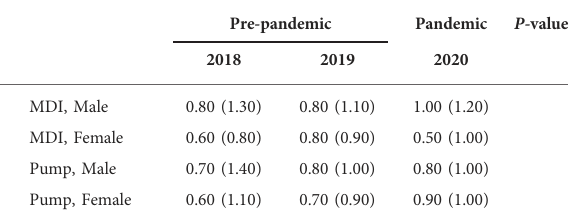
TABLE 1 Characteristics of study